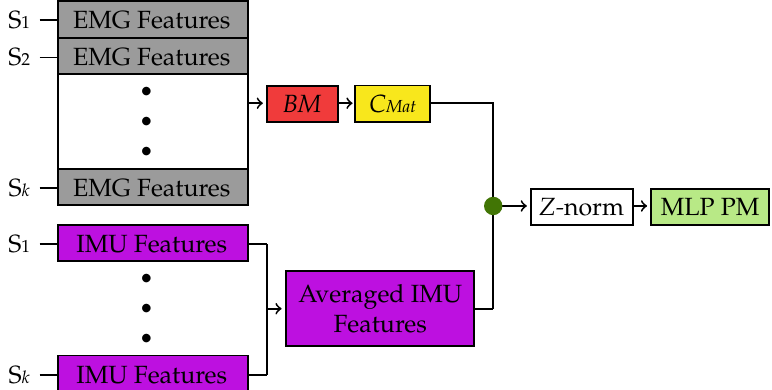
Figure 6. Training and testing flow for the Bilinear Model-based classification method during each cross-validation iteration using both EMG and IMU data. A similar procedure was used for the EMG only dataset. EMG data (grey) from each Subject S 1 to Subject S k in the training folds are stacked together to form a single matrix. A bilinear EMG model (red) is created from this matrix and then, motion-dependent factors (yellow) are extracted from the bilinear model. These motion-dependent factors are fused with the averaged IMU features from the same subjects (purple) in the training folds. Finally, an MLP predictive model (green) is created using the fused data. The green dots represent a feature-level